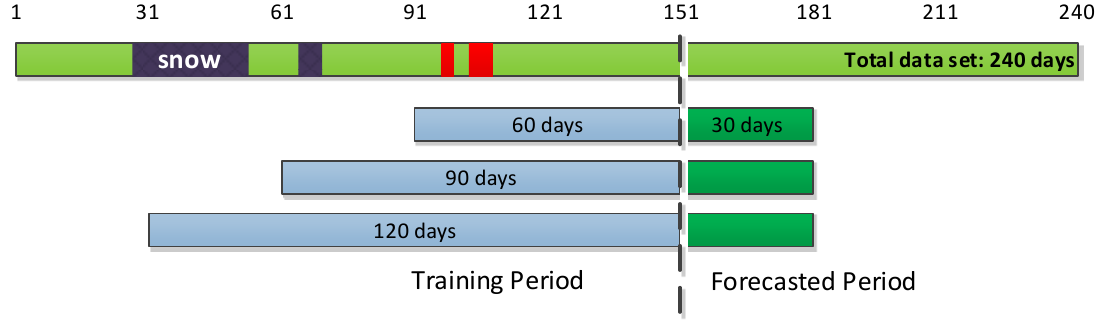
Figure 5. Scheme of the 30 consecutive forecasted days with a different size of the training